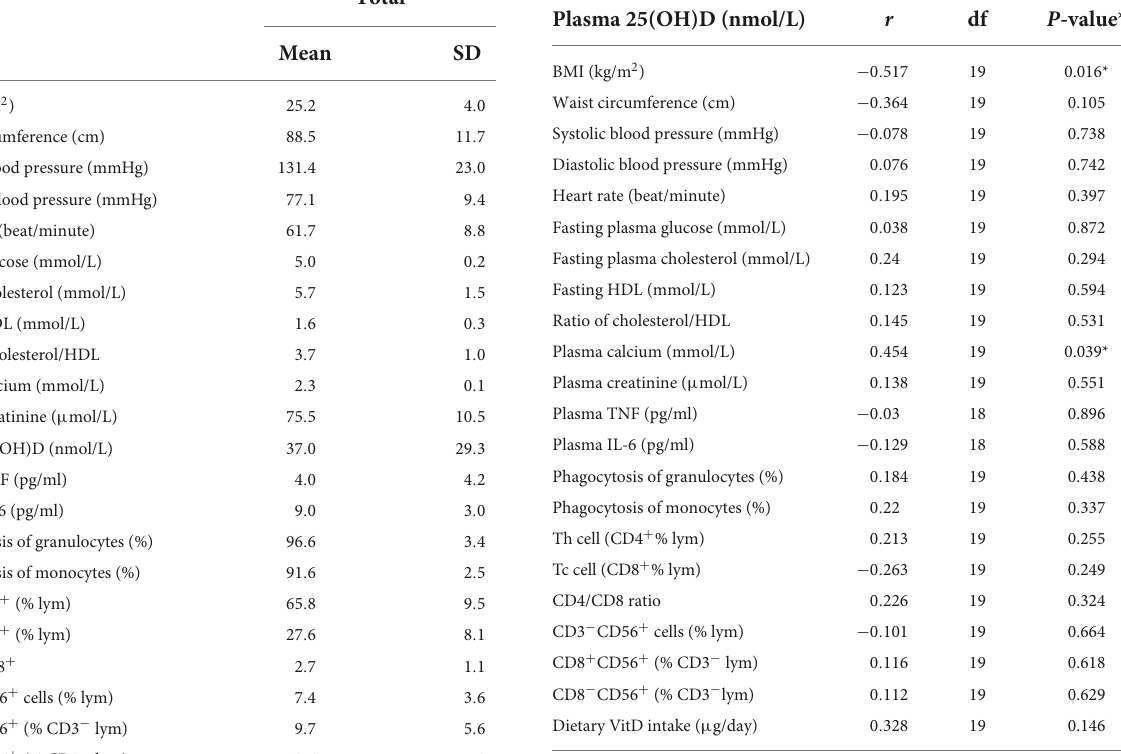
TABLE 2 Baseline measures of the participants. TABLE 3 Baseline association of plasma 25(OH)D concentrations with different